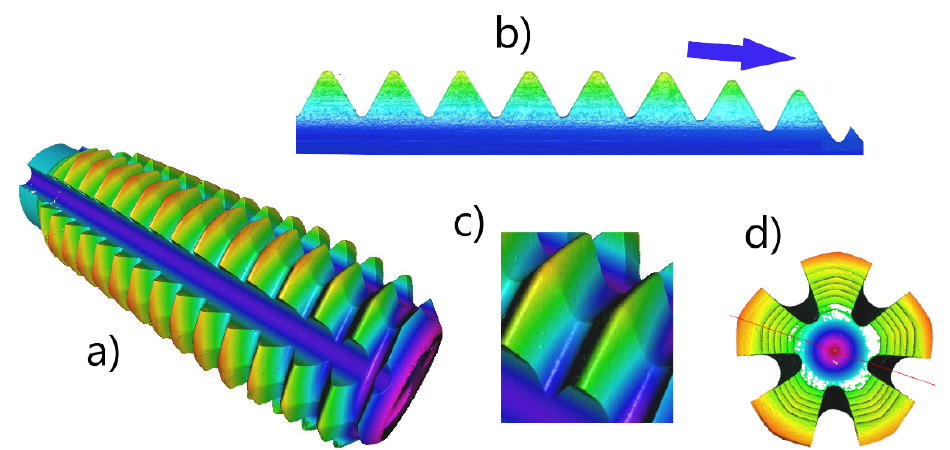
Figure 4. The forming tap geometry—a very good access of fluids to penetrate into tool–workpiece interface; ( a ) an overview of the tool, ( b ) the descending order of the forming tips, ( c ) the wedged profiles, ( d ) a front view of the tool.